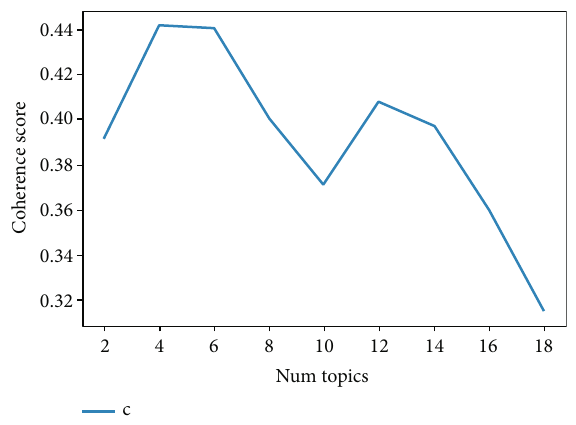
Figure 1: Value of CV coherence in the number of di ff erent